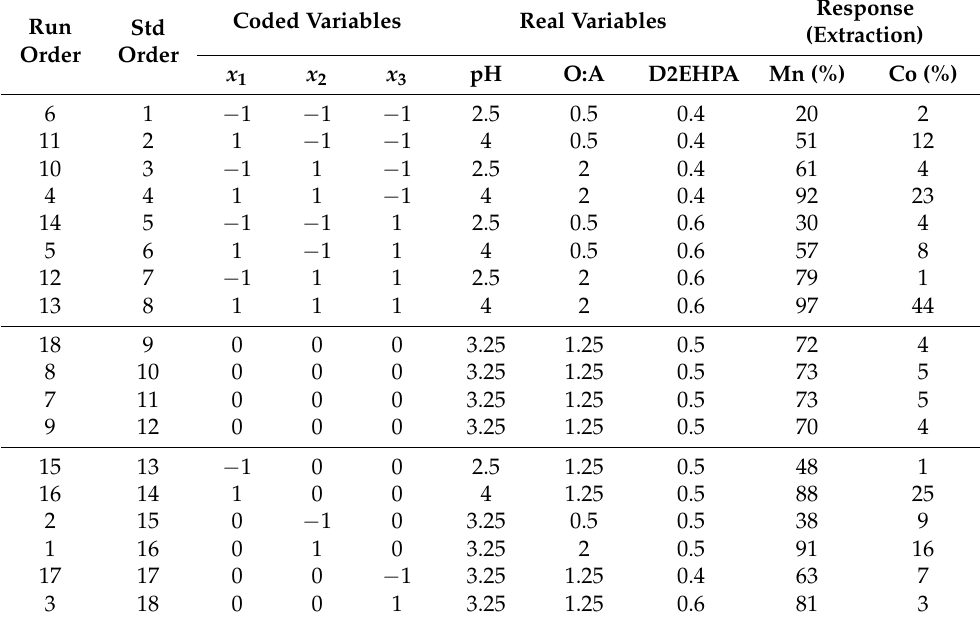
Table 3. Conditions of the experimental design and results for the extraction of manganese and